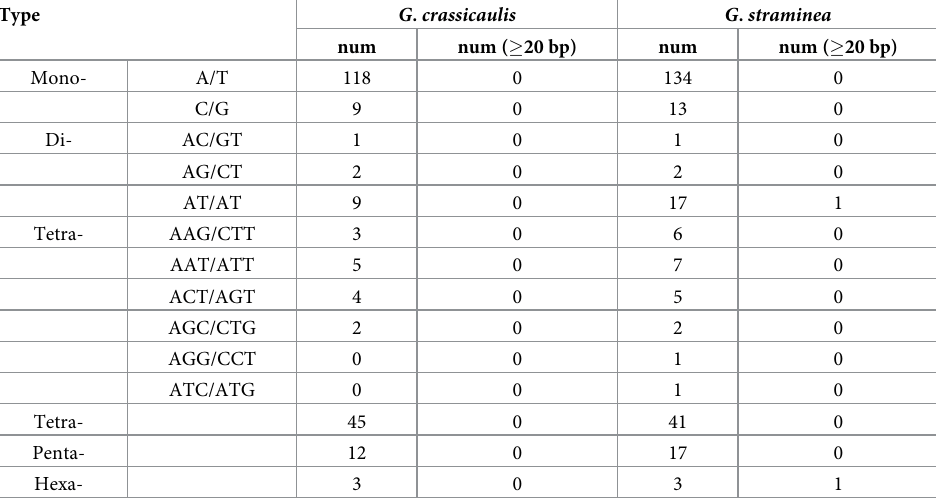
Table 2. SSRs identified in the mitochondrial genomes of Gentiana crassicaulis and G . straminea .